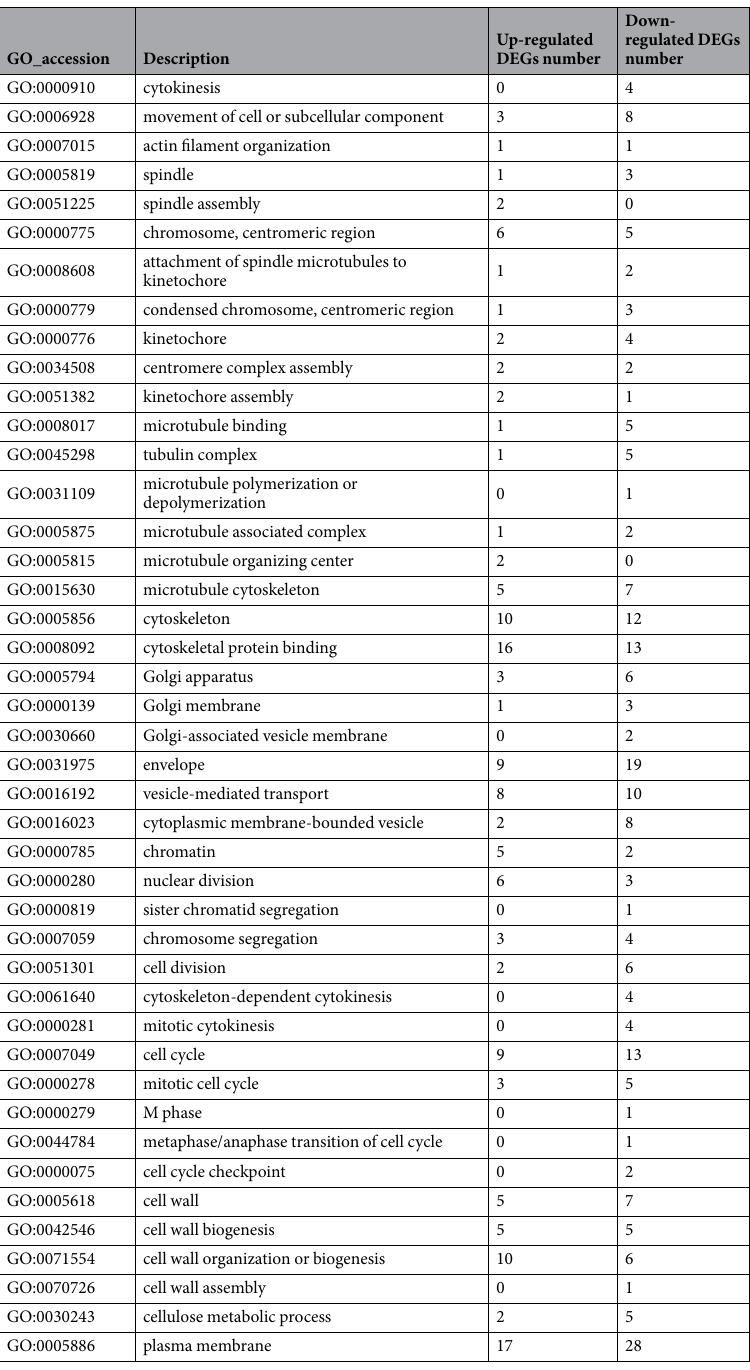
Table 3. Part of the GO terms which were Screened out related to mitosis in cell